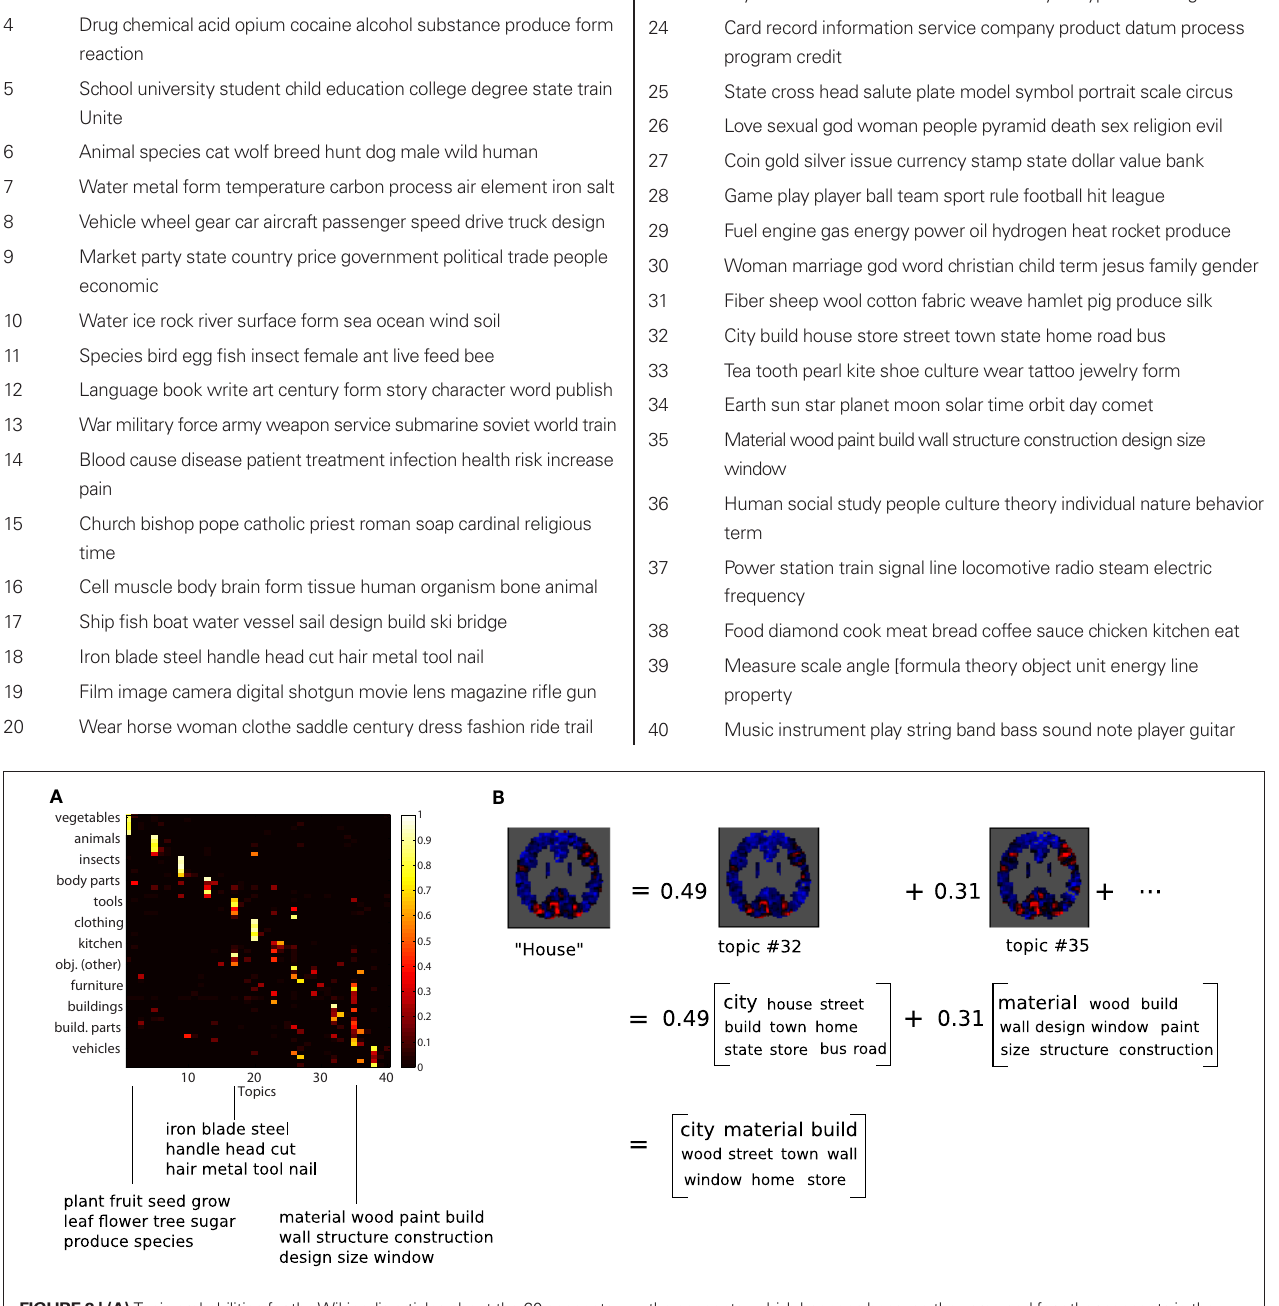
FIguRe 2 | (A) Topic probabilities for the Wikipedia articles about the 60 concepts for which we have fMRI data. Each concept belongs to one of 12 semantic categories, and concepts are grouped by category (five animals, five insects, etc.). Note that the category structure visible is due to how we sorted the columns for display; the model is trained in an unsupervised manner and knows nothing about category structure. Note also that there are topics that are not probable for any of